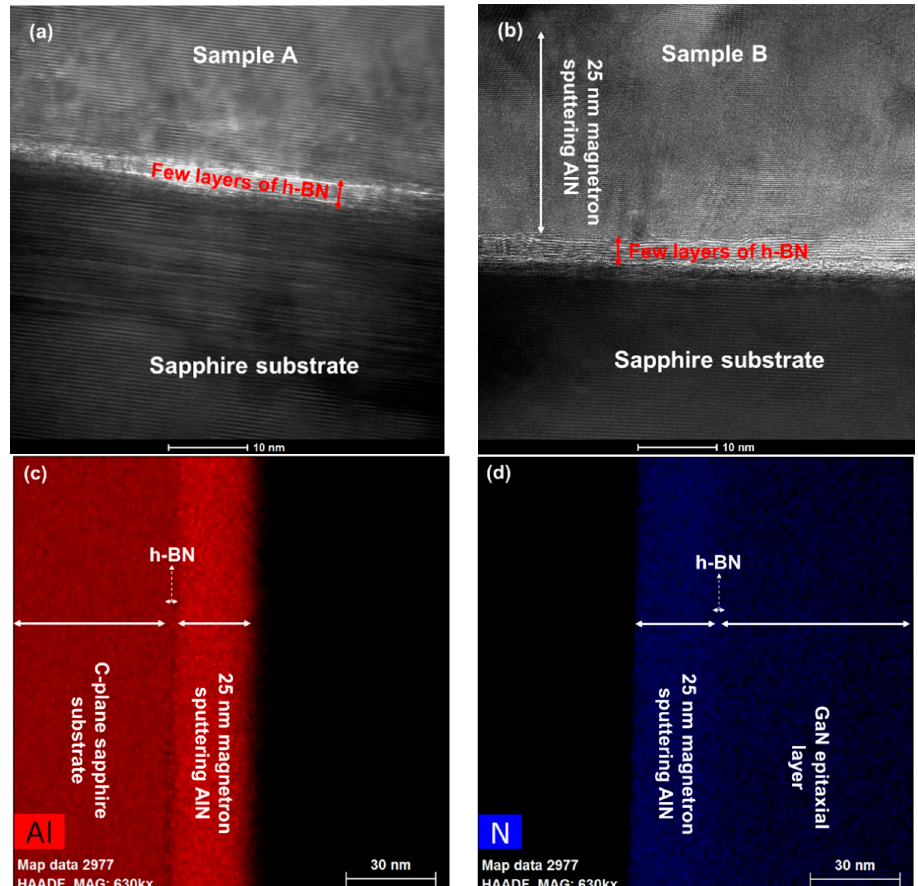
Figure 3. High-resolution TEM cross-sectional view of ( a ) sample A and ( b ) sample B. Energy dispersive spectroscopy (EDS) diagrams of ( c ) Al element and ( d ) N element.